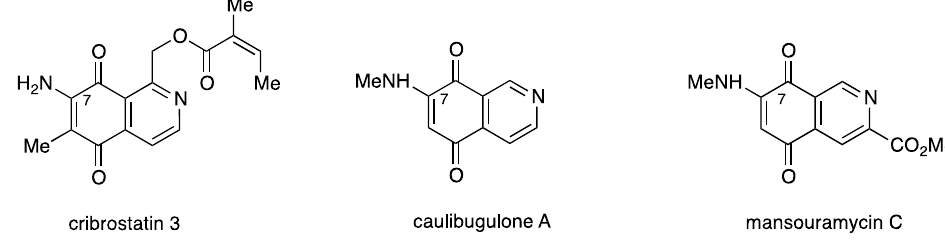
Figure 1. Structures of naturally occurring 7-aminoisoquinolinequinones with anticancer activity.